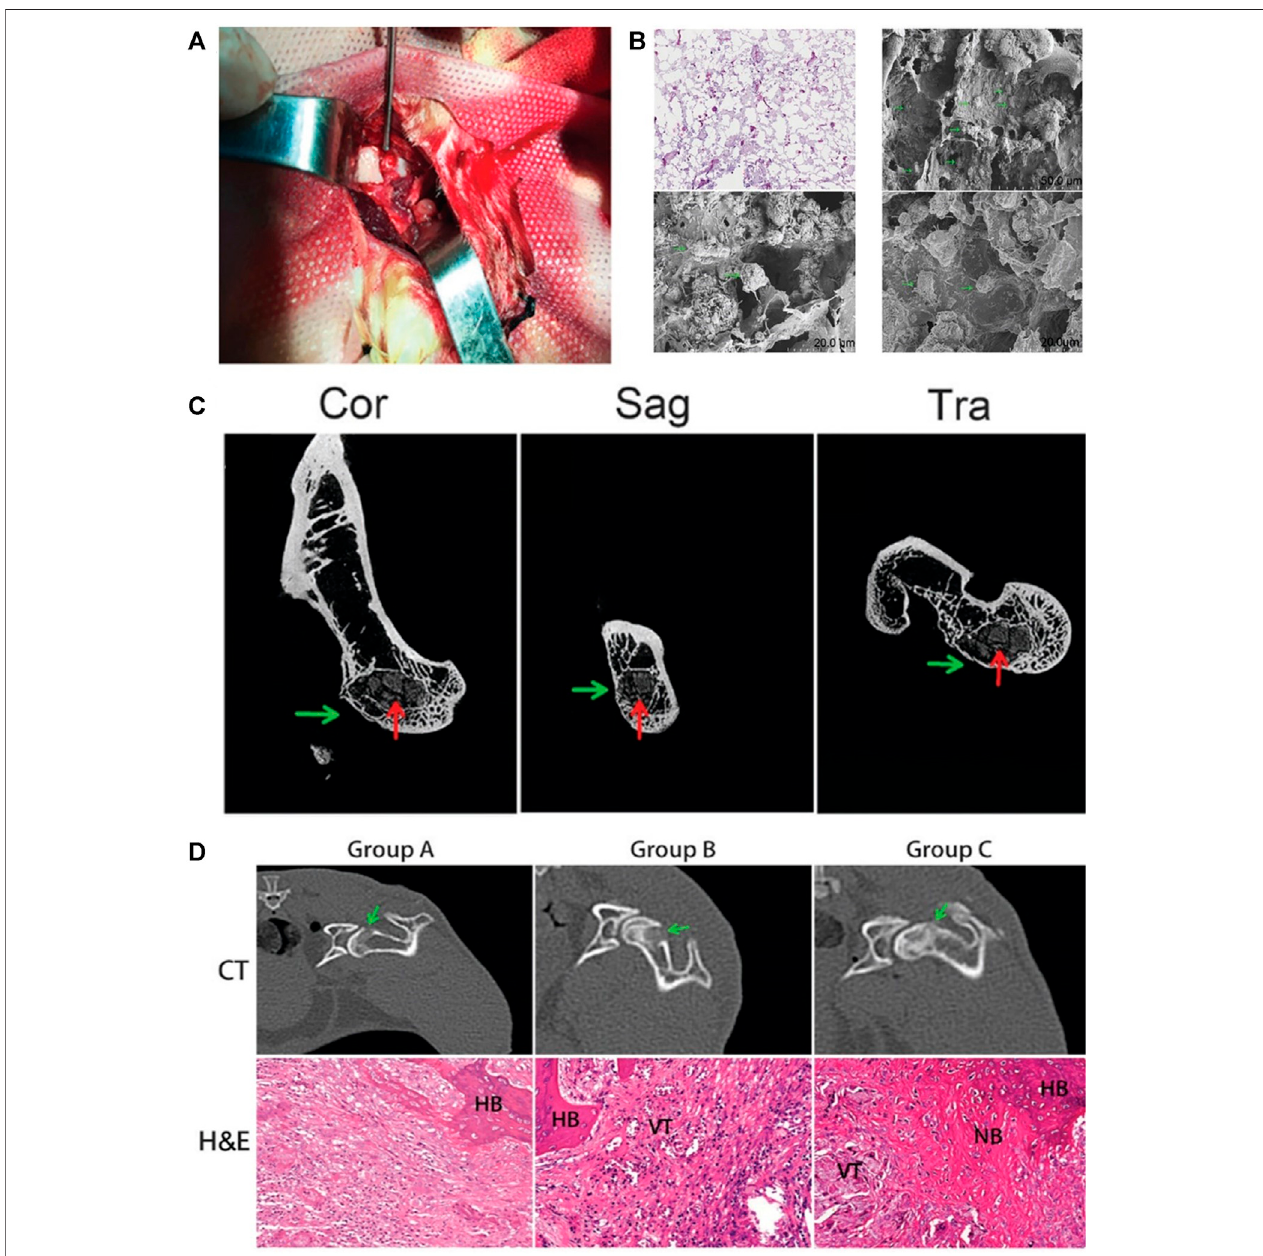
FIGURE 8 | PLA-based composite scaffolds may improve the curative effect of CD and provide a strategy for treating ANFH. (A) composite scaffolds were implanted into the decompression tunnel. (B) A total of 24 h after seeding, hematoxylin and eosin staining and scanning electron microscopy micrographs revealed that BMMSC attach to scaffolds. (C) The micro-CT results further showed more bone trabeculae around the decompression tunnel in group C. (D) CT images and HE micrographsat4 weekspost-operation.TheCTimagessuggestedthattheosteogenesisinthedecompressiontunnelofgroupCwassigni fi